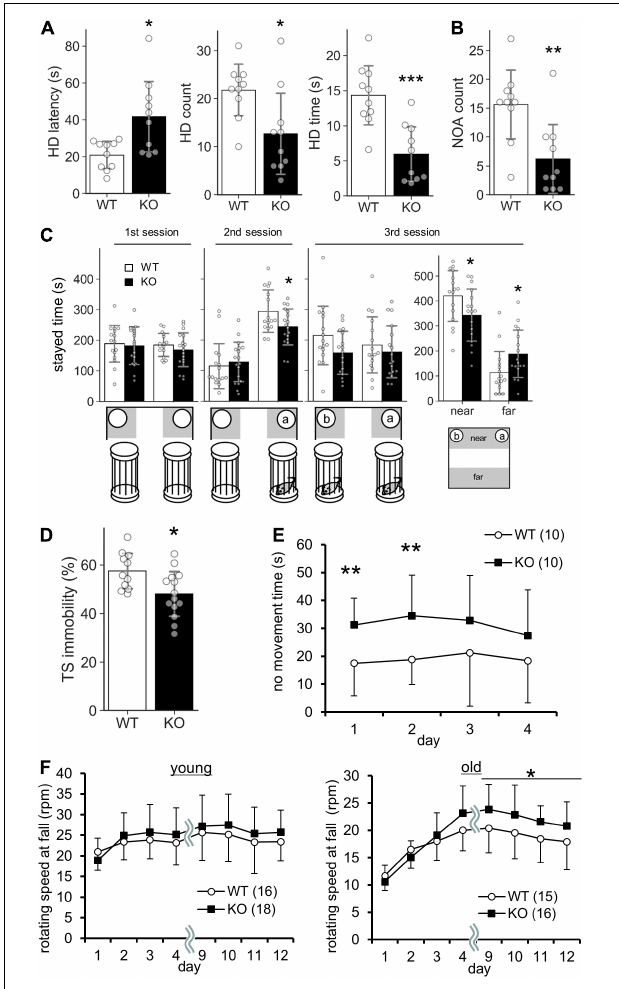
FIGURE 5 | Behavioral abnormalities of Lrtm2 KO mice. 2–6-month-old male were subjected for systematic behavioral analysis. Results for additional parameters for the above tests and additional test subjects are indicated in Table 2 . (A) Hole board test. Mice are placed in an open field box with holes for 5 min. Left, head dip (HD) time latency. Middle, HD count. Right, total HD time. WT, n = 10, KO, n = 10. (B) Novel object approach (NOA) test. Mice are placed in an open field with an unfamiliar object (inverted paper cup). The number of contacts is counted. WT, n = 10, KO, n = 10. (C) Social discrimination test. Bottom, experimental design. Graphs indicate the time spent in the gray areas indicated below. near , the region close to the caged mice; far , the region distant from the caged mice. WT, n = 10, KO, n = 10. (D) Tail suspension test. The percentage of immobile time in 5 min test period is measured. WT, n = 10, KO, n = 13. (E) No movement time in the water maze test. WT, n = 10, KO, n = 10. (F) Rotarod test. The tests are carried out daily on days 1–4 and days 9–12. The stayed time on accelerating rotarod is measured. WT, n = 16, KO, n = 16–18. * p < 0.05; ** p < 0.01; *** p < 0.001 in Welch’s t -test (1A, HD latency), U -test (D) , and Student’s t -test (the others). Error bars , SD. (A–D) Gray circles indicate the individual value of each mouse. (E,F) The numbers in parentheses indicate n (the number of mice) in each experimental group.